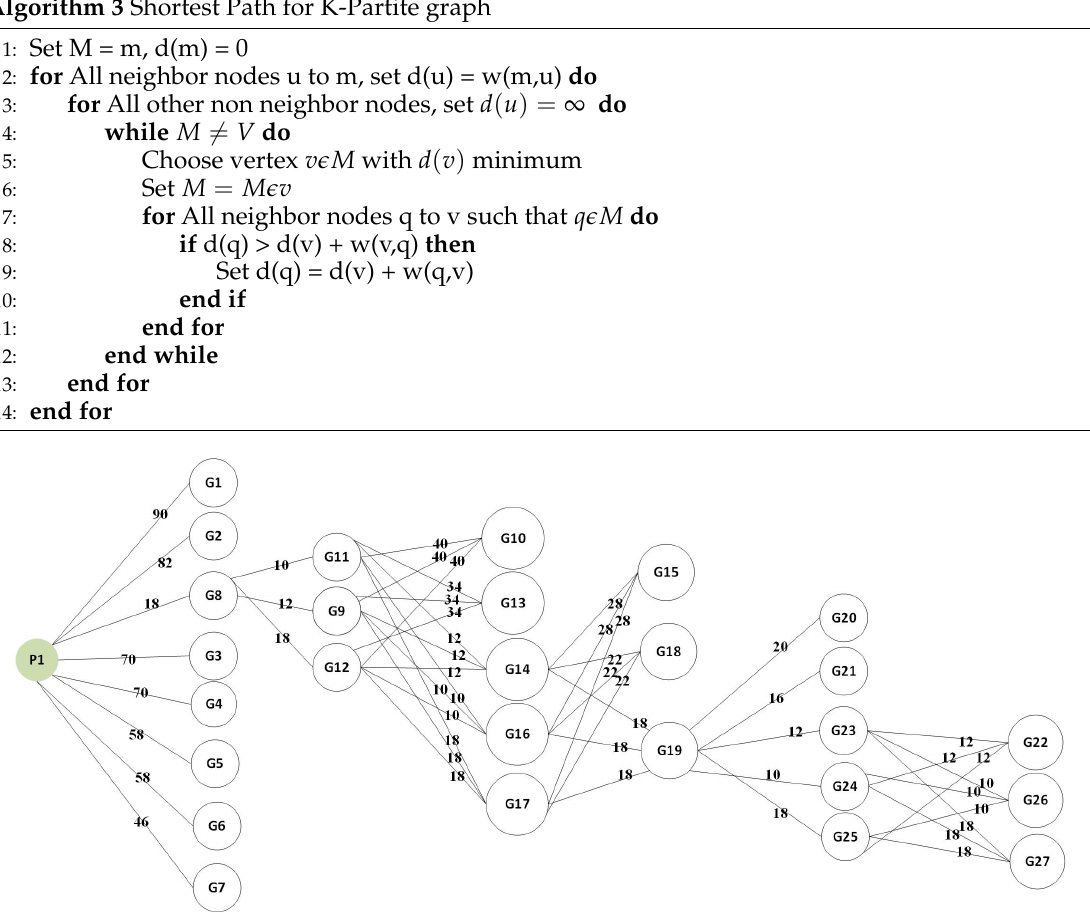
Figure 15. K-partite Graph with scaled values of number of rules and number of transmissions. Shortest path for this K-partite graph is calculated that gives the optimal policy implementation